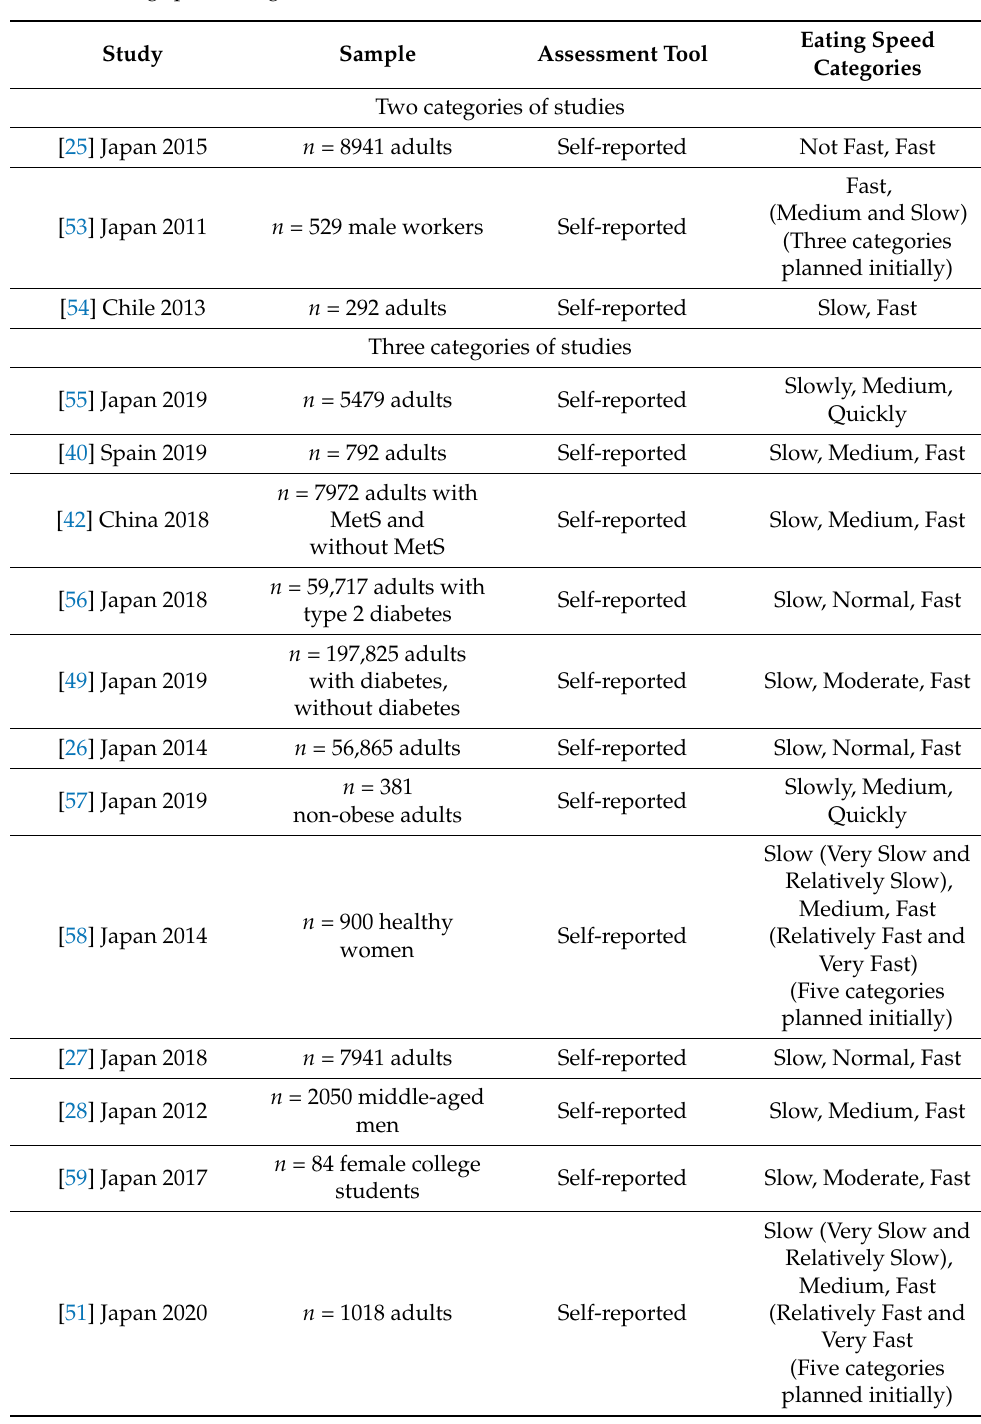
Table 1. Eating speed categories of the reviewed